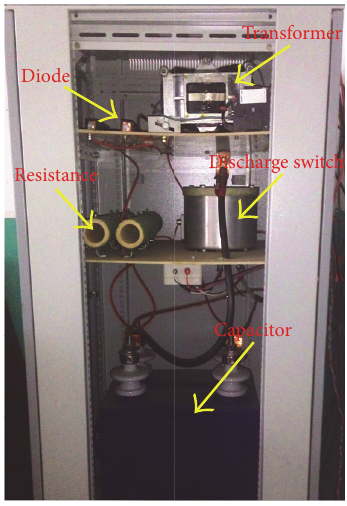
Figure 3: Actual high voltage pulse power